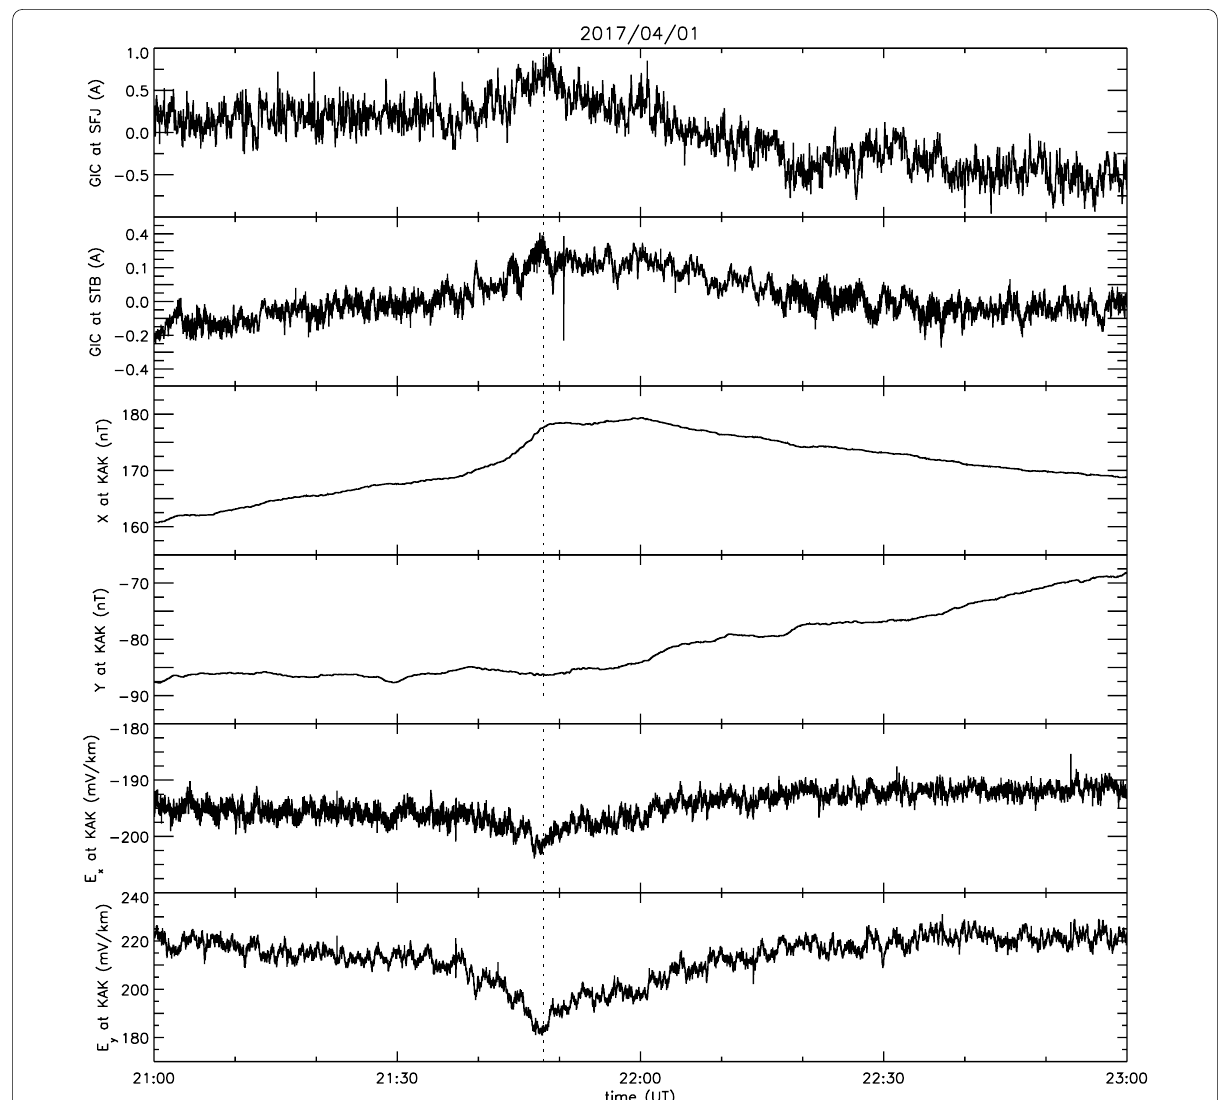
Fig. 9 GIC at SFJ and STB, and X- and Y-components of geomagnetic and geoelectric fields at KAK associated with the SFE caused by the M4.4/1F flare on 1 April 2017. The dotted vertical line shows the time of the maximum phase of the